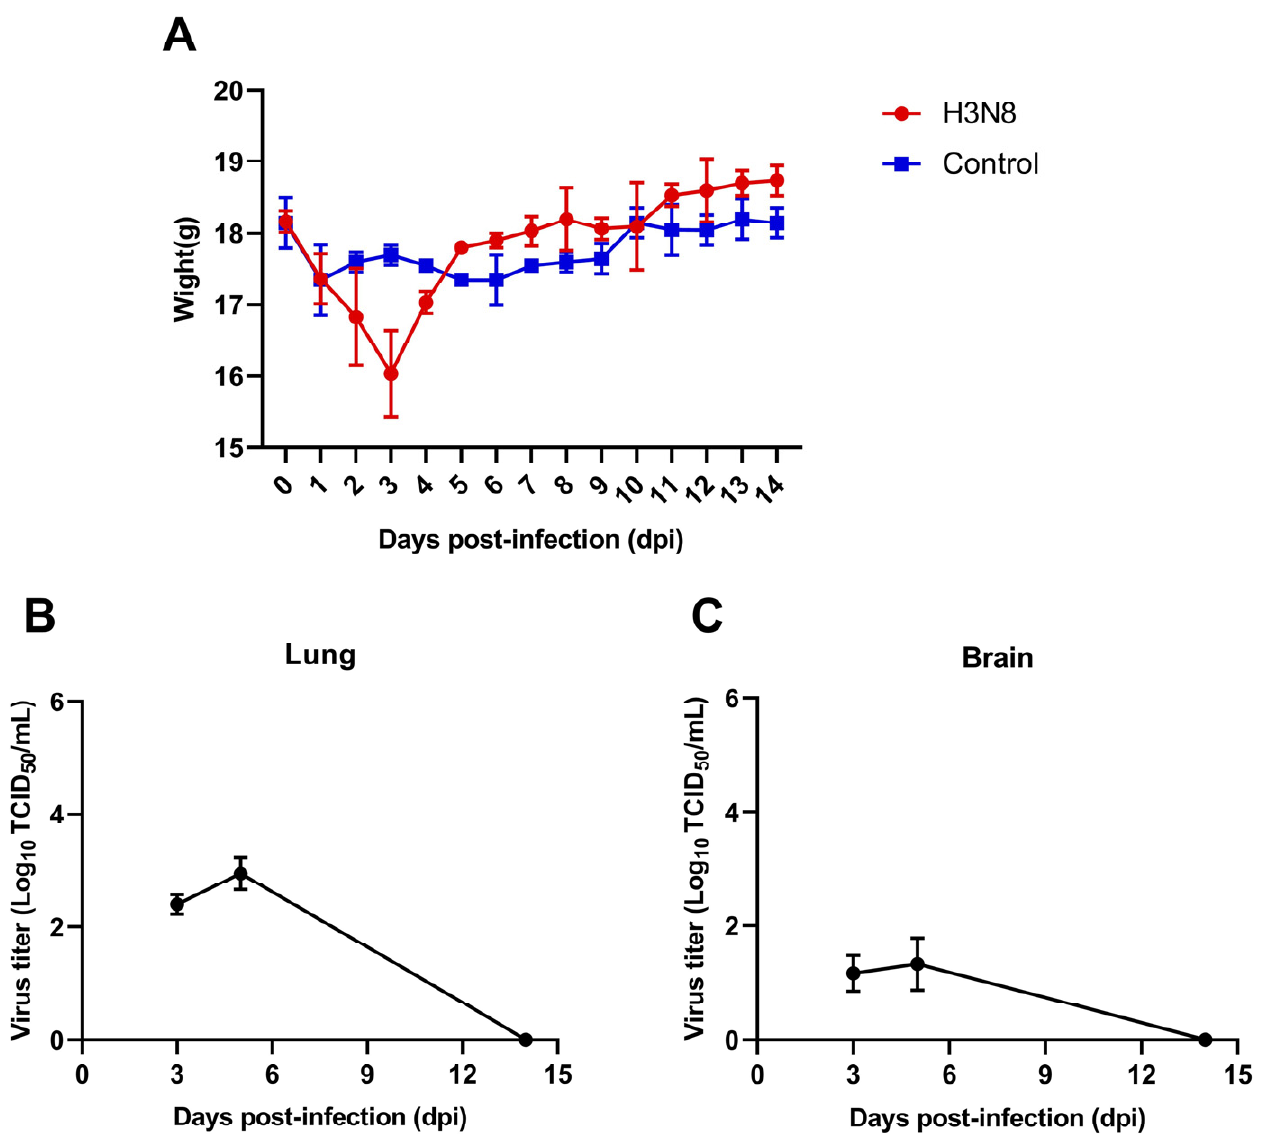
Figure 5. Pathogenicity of the H3N8 (JX 5-1) isolate in vivo. For each virus strain, BALB/c mice were intranasally infected with 10 6 EID 50 /mouse concentrations of the virus. ( A ) Mean body weight (n = 3), ( B ) virus titer in the lung at 3 dpi, 5 dpi and 14 dpi ( n = 3), ( C ) virus titer in the brain at 3 dpi, 5 dpi and 14 dpi.